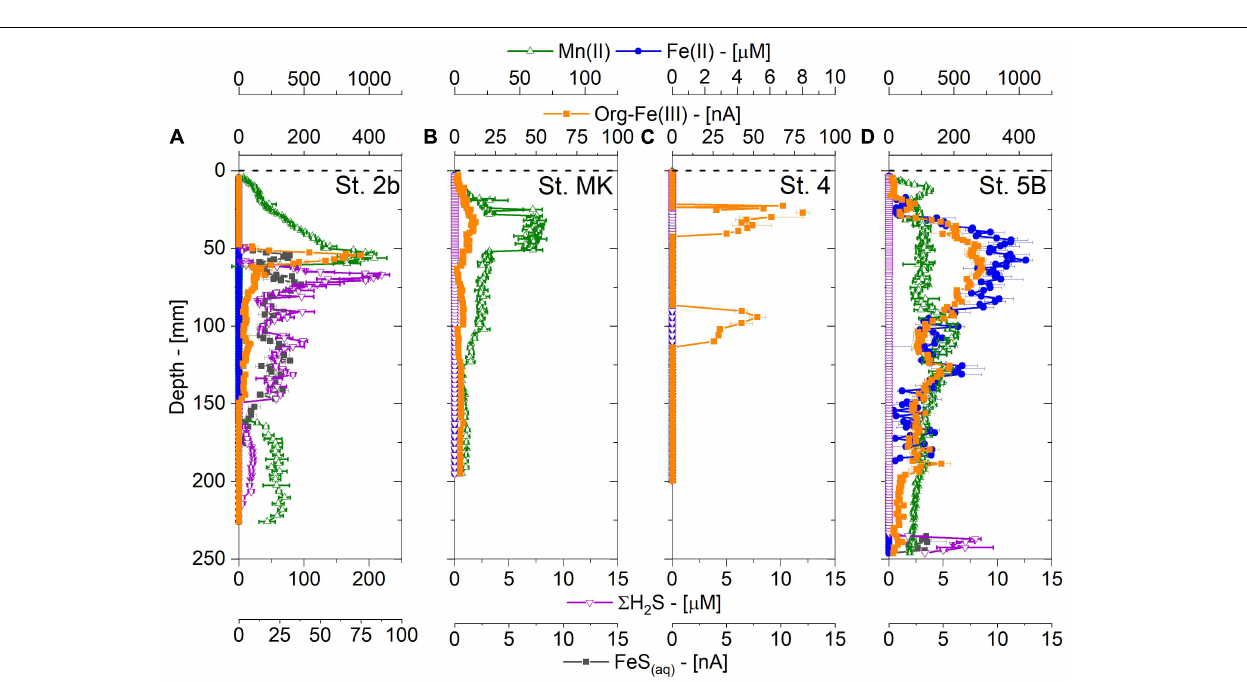
FIGURE 7 | Dissolved iron (Fe dissolved ) spatial distribution obtained by diffusive equilibrium in thin films (2D-DET) (colored panel) and dissolved Fe averaged profiles obtained from DET (black dots and line) compared to extracted pore water profiles (red dots) at the four stations on the Louisiana shelf in July-August 2017. Gray contours represent 1 σ of the distribution of dissolved Fe for each line of pixel.